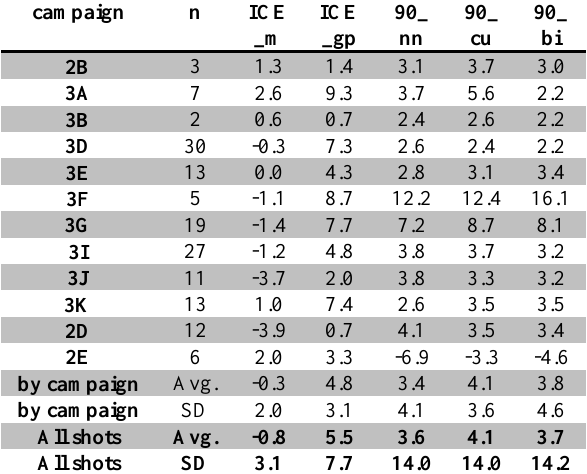
Table 4. Results of ICESat/GLAS campaigns (one